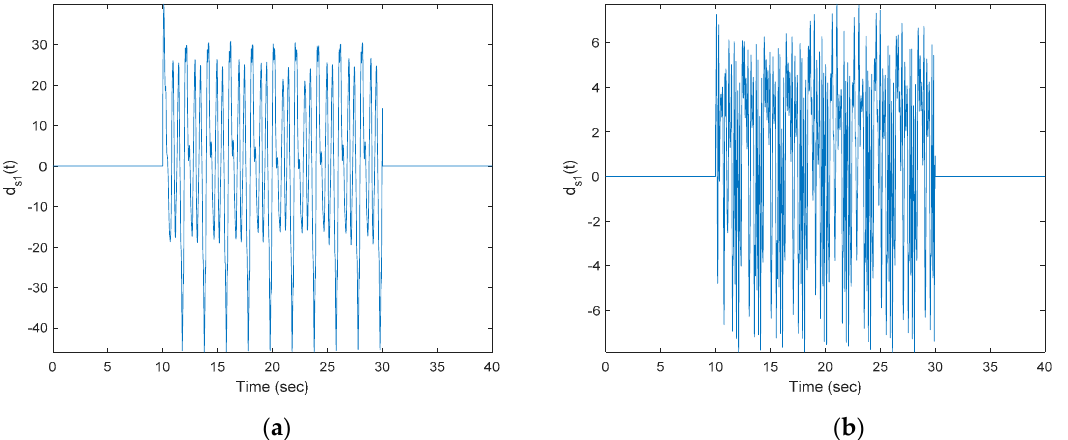
Figure 3. ( a ) Input disturbance d s 1 ( t ) (state-dependent disturbance inside) and ( b ) state-dependent disturbance in d s 1 ( t ) .